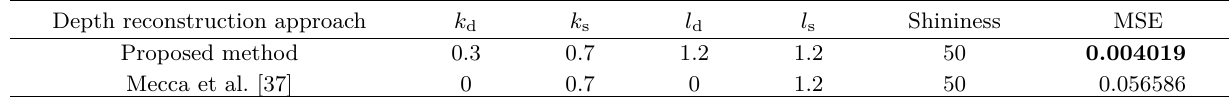
Table 3 MSE of the reconstructed depth from images with high specularities shown in Fig. 12 Depth reconstruction approach